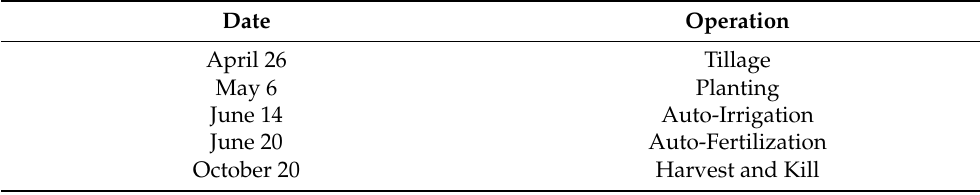
Table 1. Annual crop schedules for soybean crops established in the Big Sunflower.